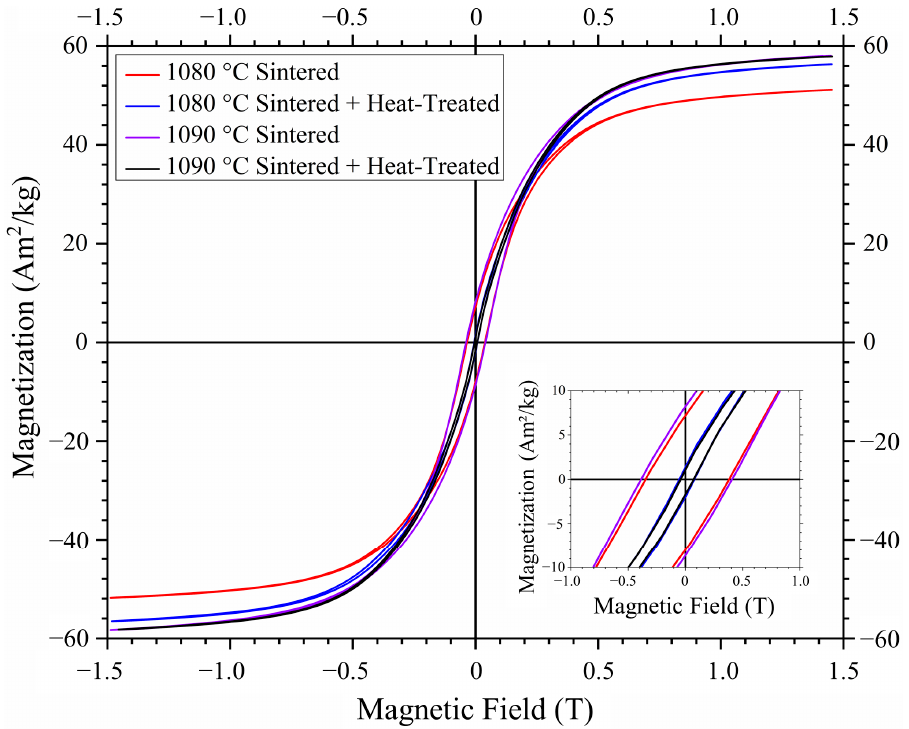
Figure 8. Magnetization (M–H) curves comparing saturation magnetization and coercivity for the different sintering and post-processing conditions. Inset is a magnified view of the hysteresis (note the unit change on the horizontal axis).